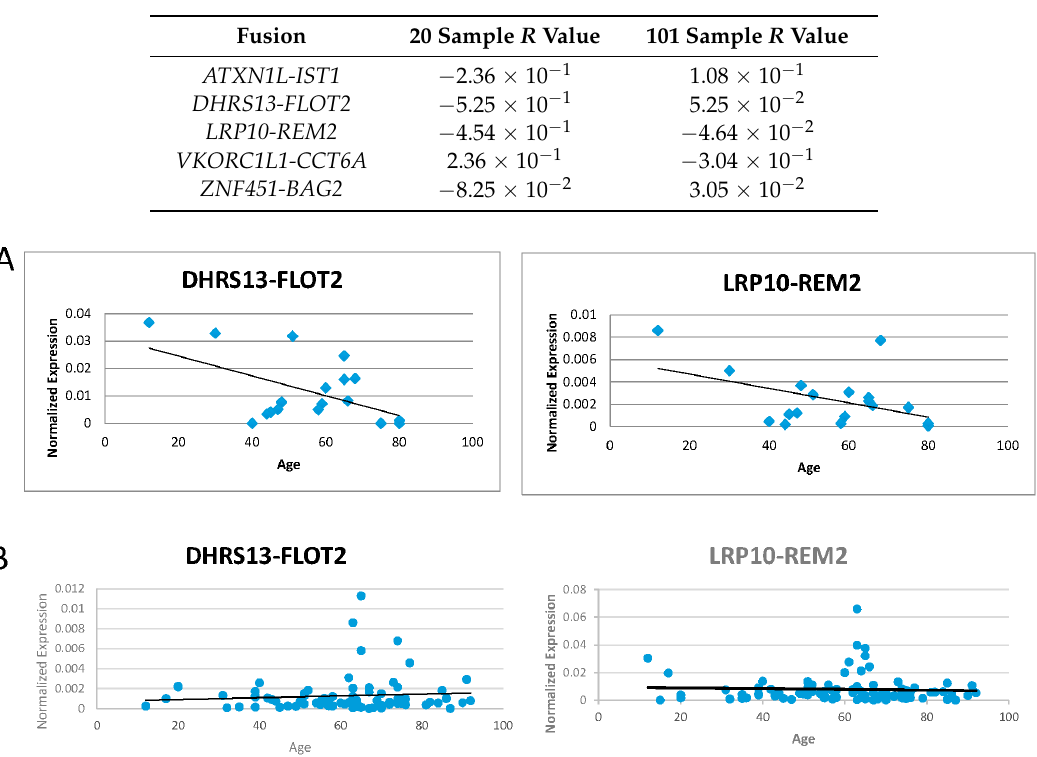
Figure 3. Correlation of fusion RNAs with aging. ( A ) DHRS13-FLOT2 and LRP10-REM2 (both forms) normalized expression levels graphed against age with 20 samples. ( B ) DHRS13-FLOT2 and LRP10-REM2 (both forms) normalized expression levels graphed against age with 101 samples.